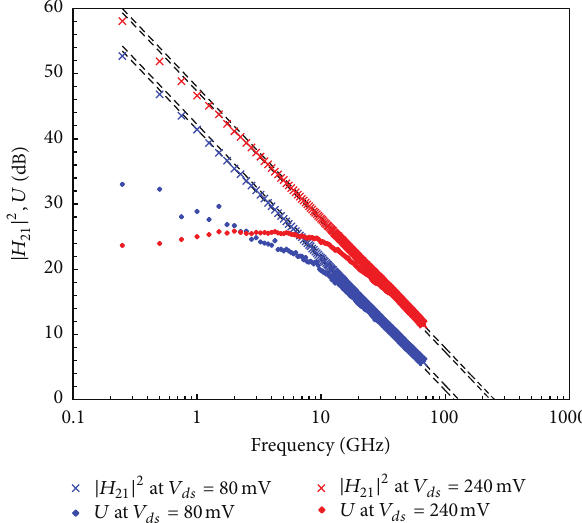
Figure 4: 𝑓 max and 𝑓 𝑇 extrapolated from Mason’s unilateral gain 𝑈 and current gain |𝐻 21 | 2 for 𝑉 𝑑𝑠 = 80 mV and 𝑉 𝑑𝑠 = 240